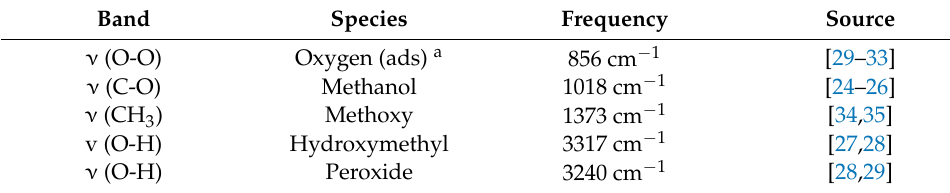
Figure 5. Evolution of the ATR spectra after the switch from water to methanol. Table 1. Overview of important bands during the ATR